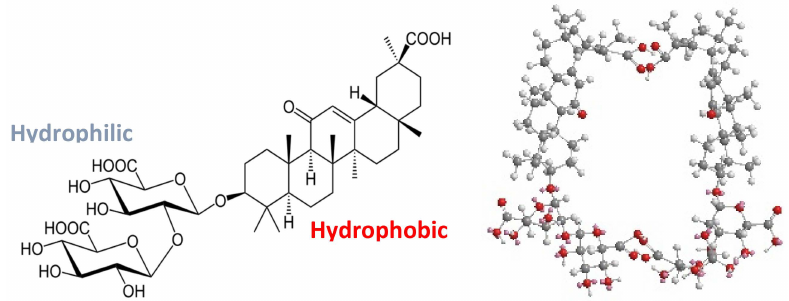
Figure 3. The structures of glycyrrhizic acid monomer and